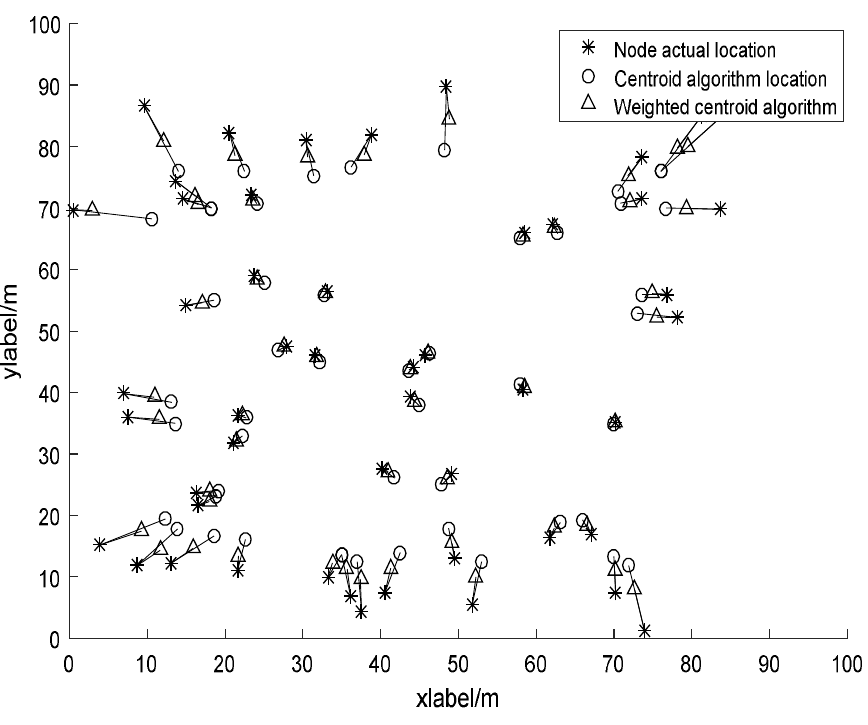
Figure 3. Node distribution of Figure 3 . Node distribution of WSNs.